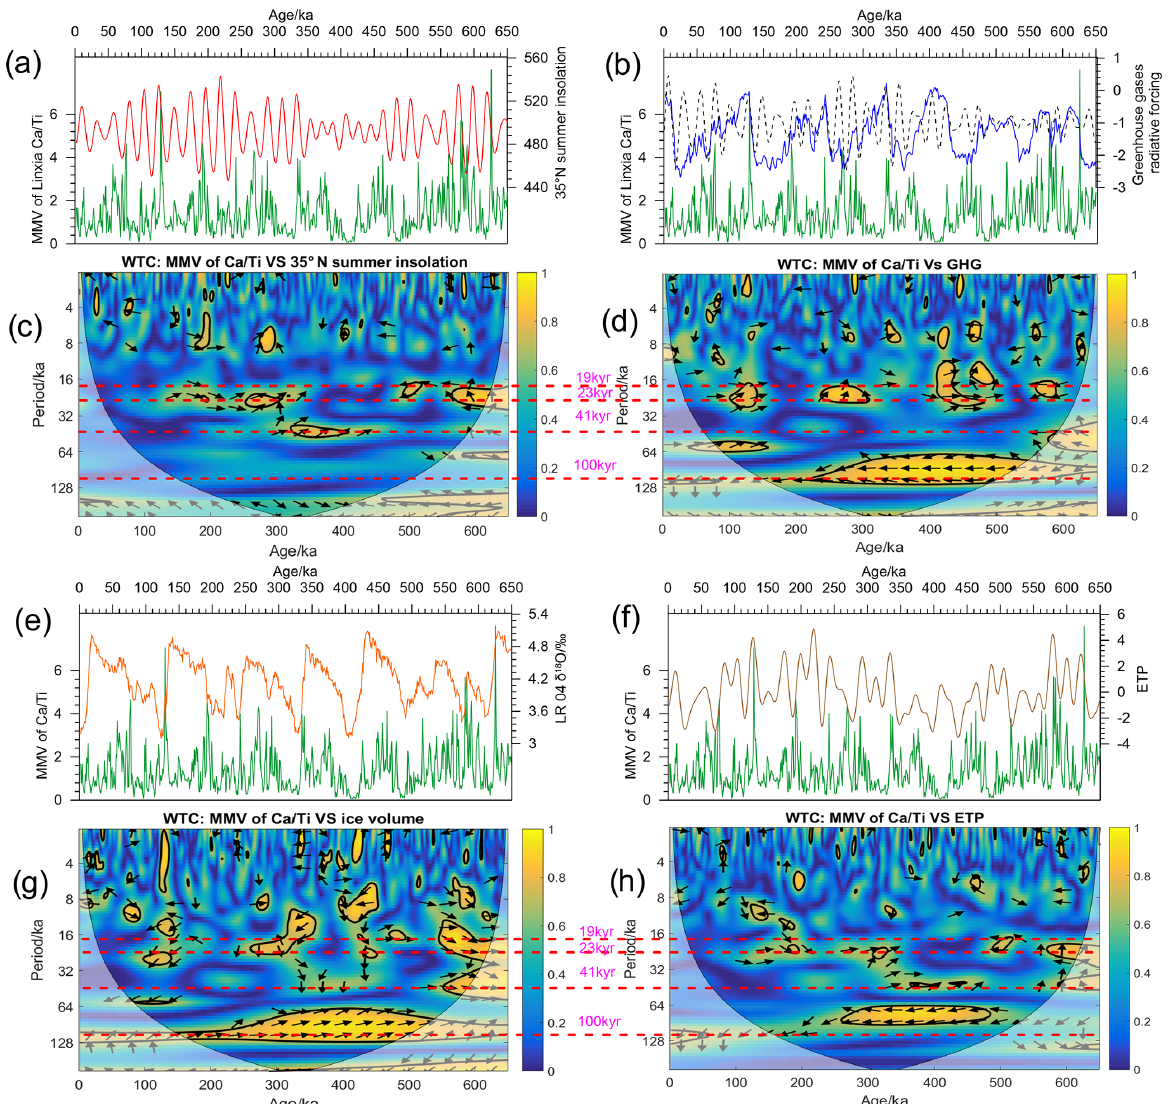
Figure 4. Comparison of (a) 35 ◦ N summer insolation forcing, (b) GHG radiative forcing (black dashed line denotes the precession band- pass filtering results of (cid:49) RF GHG ) and (e) ice volume and (f) ETP for MMV of Linxia loess Ca / Ti. Wavelet coherence between (c) 35 ◦ N summer insolation, (d) GHG radiative forcing, (g) ice volume, (h) ETP and MMV of loess Ca / Ti over the past 650kyr. The orbital bands are marked with red dashed lines. The orange color indicates strong correlation for the two time series. The black lines plot coefficients of determination greater than 0.76. The black arrows represent the phase relationship, with rightward, upward and downward arrows indicating in phase, leading phase and lagging phase, respectively. Strong eccentricity, weak obliquity and precession band ice volume modulation are observed for MMV of loess Ca / Ti. Strong eccentricity and precession band GHG modulation as well as weak summer insolation forcing are detected for MMV of loess Ca /